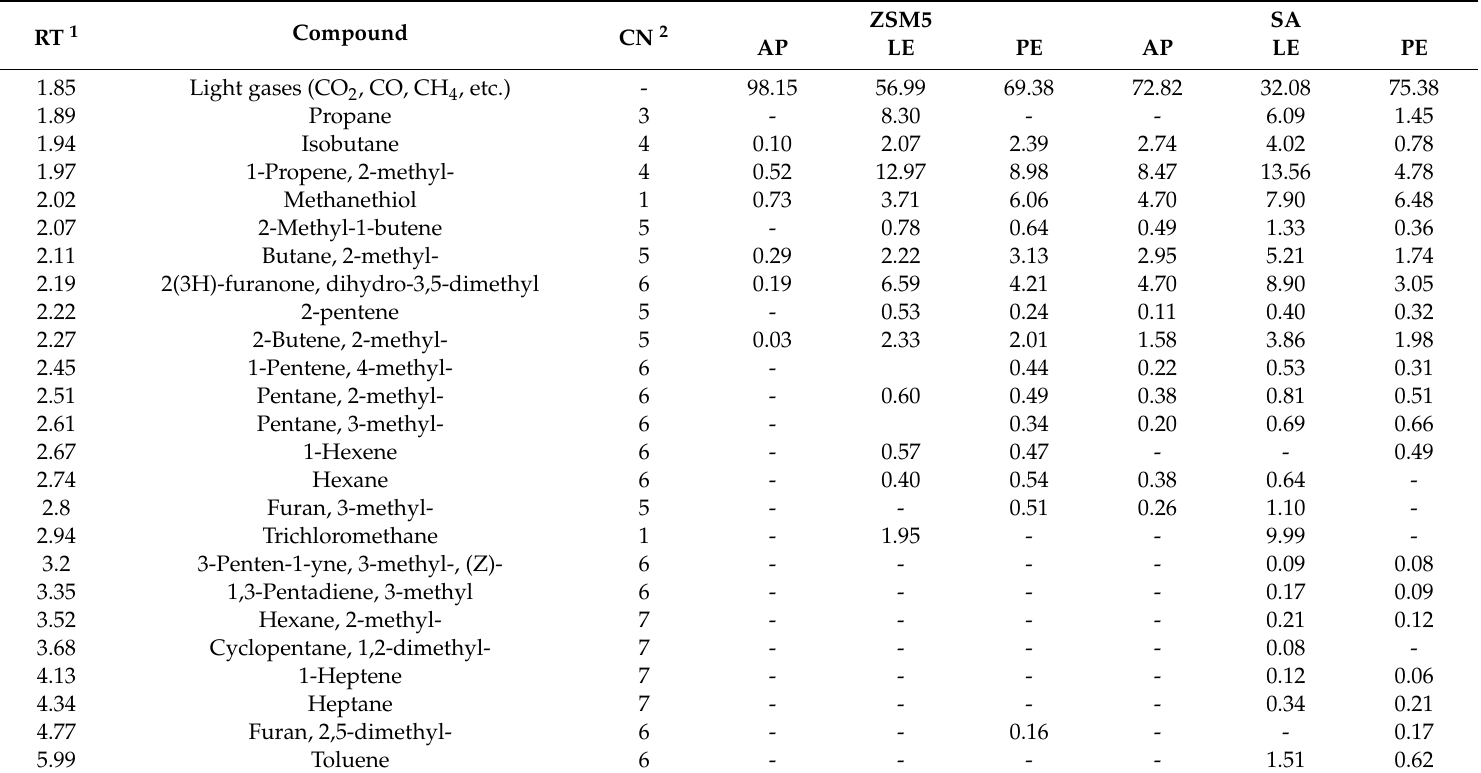
Table 2. Percentage composition (%) of gases from catalytic pyrolysis using ZSM5 or silica–alumina as catalyst in terms of individual compounds. Analytical determinations were made by GC–MS on gases from untreated Arthrospira platensis biomass (AP), biomass after lipid extraction (LE), biomass after protein extraction